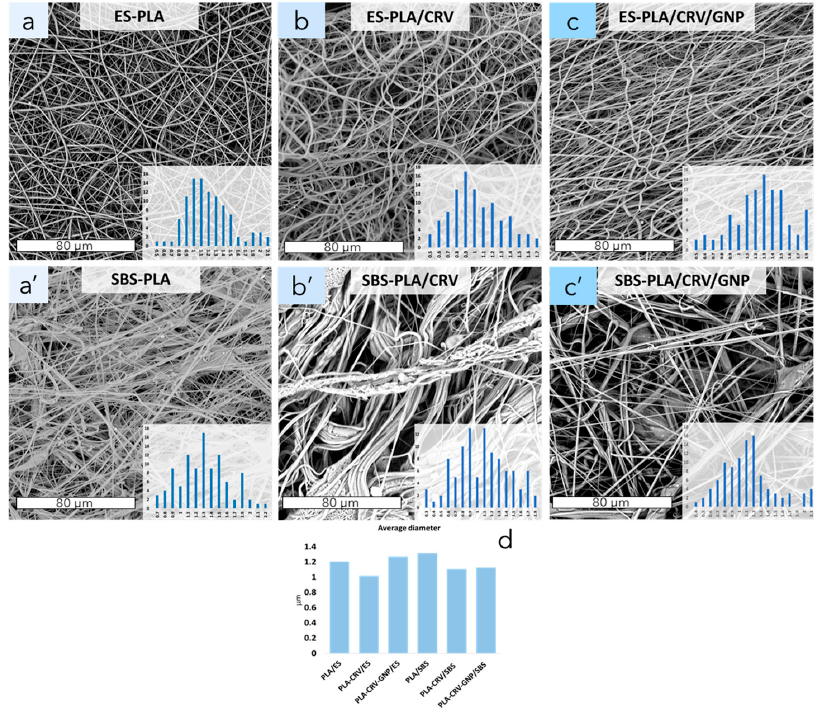
Figure 2. SEM micrographs of PLA nanofibers membranes obtained by electrospinning or